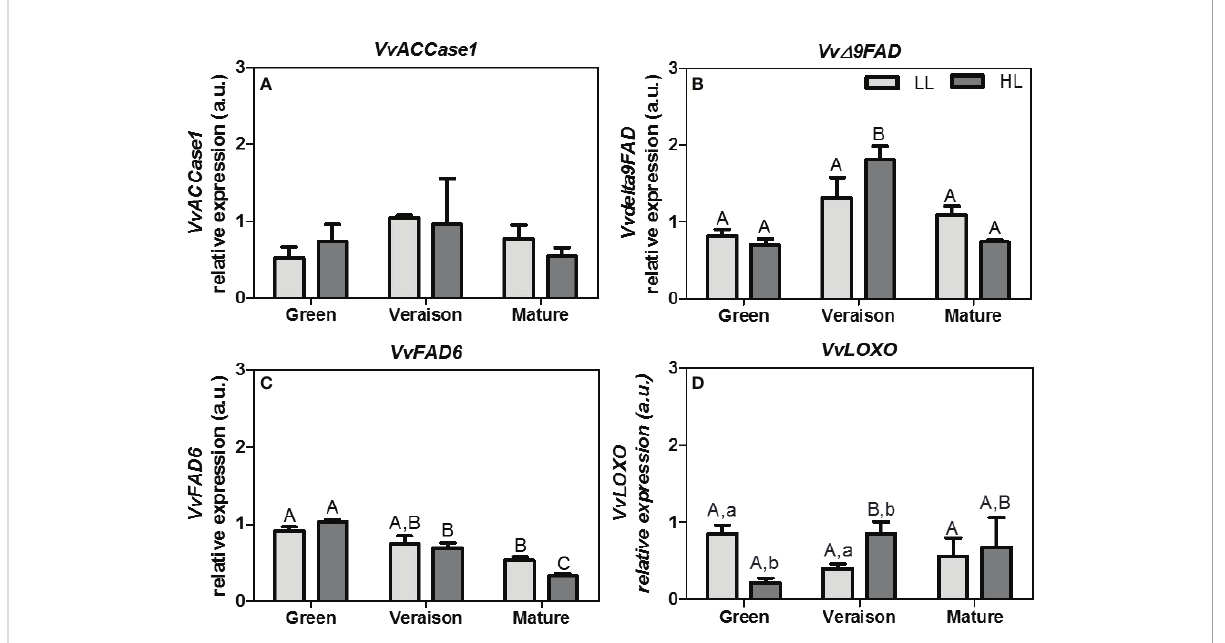
FIGURE 4 Relative expression arbitrary units (a.u.) of transcripts of: (A) acetyl-CoA carboxylase 1 ( VvACCase1 ), (B) stearoyl-[acyl-carrier-protein] 9- desaturase ( Vv D 9FAD ), (C) fatty acid desaturase-6 ( VvFAD6 ), and (D) lipoxygenase ( VvLOXO ). Gene expression analysis was performed by real- time qPCR in seeds from grapes grown at two light microclimates (low and high light, LL and HL, respectively) and at three developmental stages (green, veraison and mature). Expression levels are normalized to the mean expression of the reference genes VvACT1 and VvGAPDH . Statistical analysis (two-way ANOVA, p ≤ 0.05, n = 3) was applied after data log(x+1) transformation. Statistical notation: capital letters refer to differences between developmental stages for the same microclimate, while lowercase letters refer to differences between microclimates for each stage. When the letters are omitted, it means that the respective factor did not have a signi fi cant